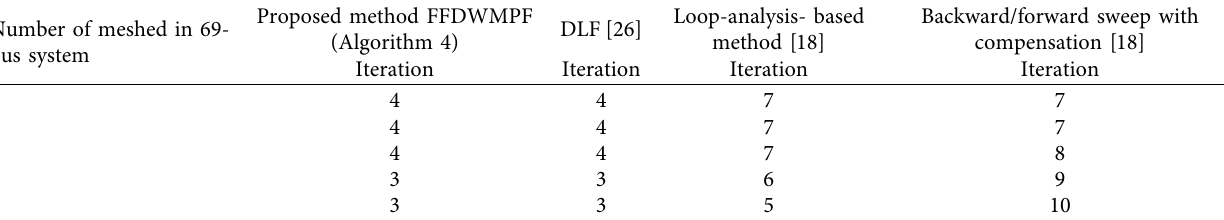
Table 6: Comparison of iterations of the balanced 69-bus weakly meshed system.